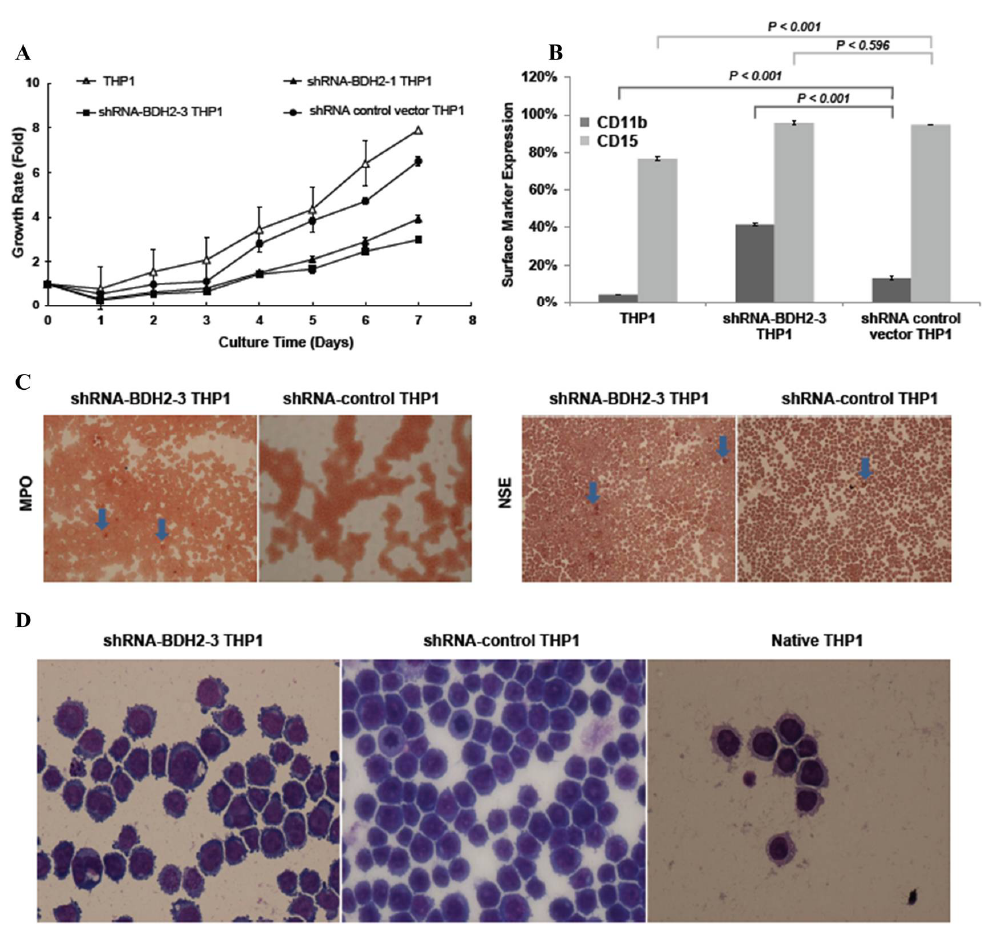
Figure 3. Cell growth rate and differentiation in BDH2 knockdown and native THP1 cells. Puromycin was used for stress selection for vector transfected cells. THP1 transfected with empty vector (shRNAc) was used as a control. ( A ) The cell growth rate in different THP1 cells. ( B ) The differentiation rate in THP1, BDH2 knockdown THP1, and shRNA control THP1 cell lines was measured by flow cytometry using the antibodies CD11b-PE and CD15-FITC. ( C ) NSE and MPO staining of BDH2 knockdown THP1 and control THP1 cells. The blue arrow indicates NSE-positive cells. ( D ) The morphology of THP1 after BDH2 knockdown. Lui stain, 40×.BDH2, hydroxybutyrate dehydrogenase type 2; CD, cluster of differentiation; MPO, myeloperoxidase; NSE, nonspecific esterase.